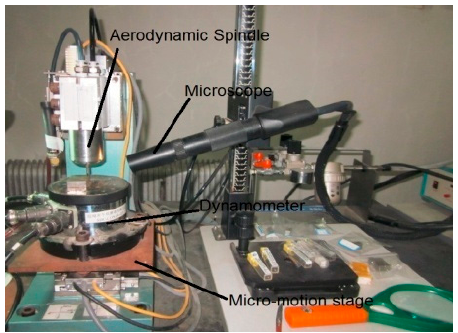
Figure 6. The micro-milling experiment.